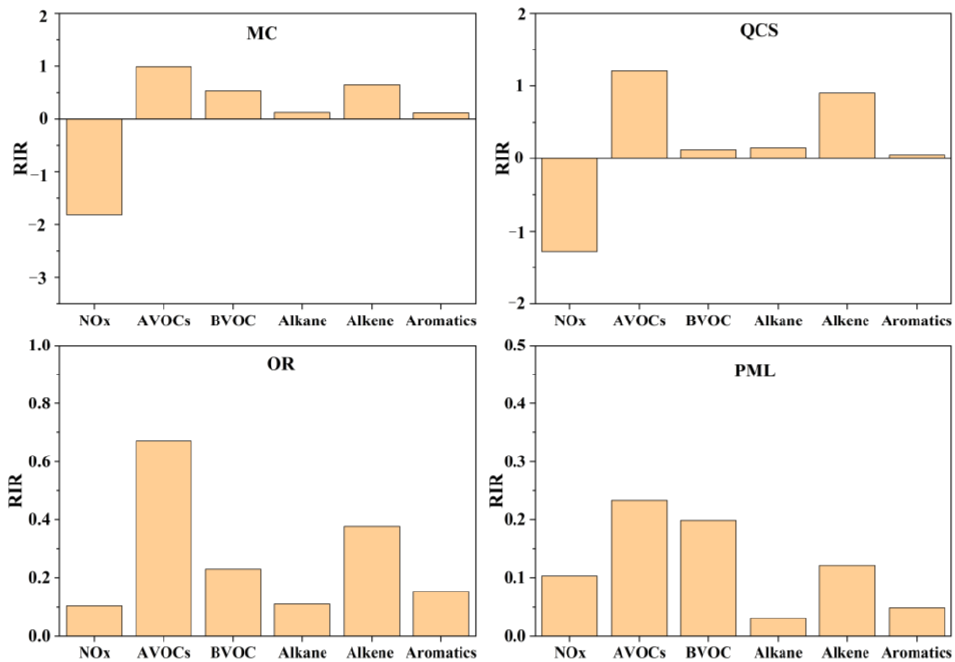
Figure 9. Empirical kinetics modeling approach curves for each site during the observation period. (The black dots represent the location of the daily hourly average volume fraction of VOCs and NO x over the observation period).